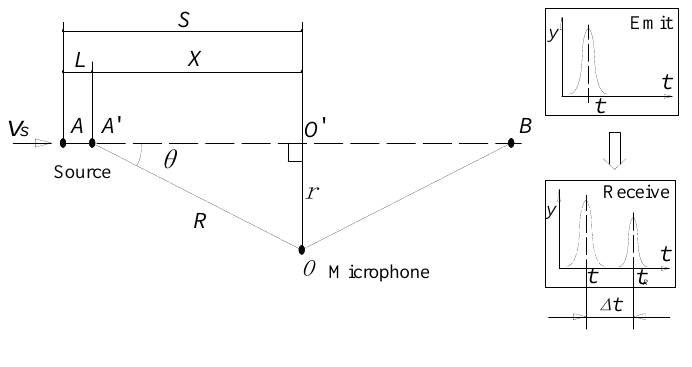
Figure 3. Depiction of a single sound source moving in a straight